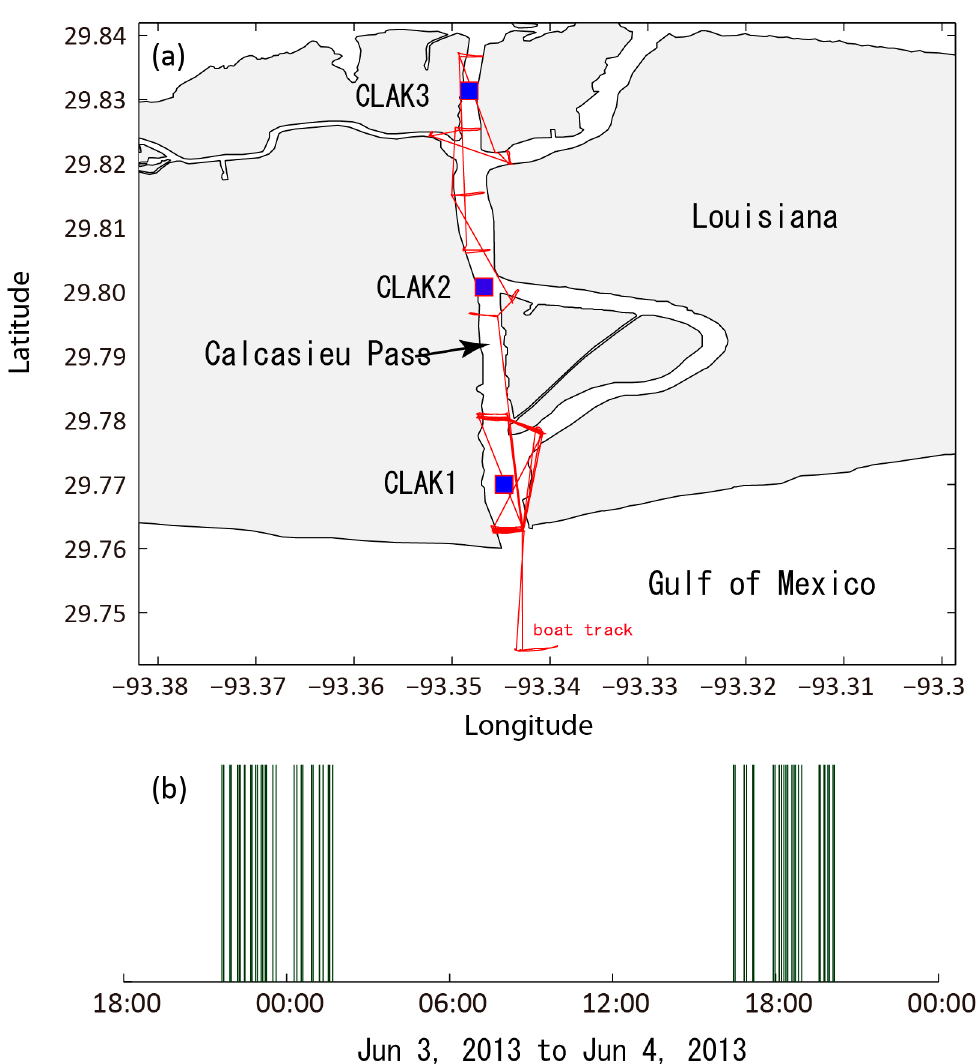
Figure 2. Boat-based survey inside the Calcasieu Pass on 3–4 June 2013. ( a ) Boat track of the survey; ( b ) the vertical bars indicate the times when the boat based survey was done across the transects. Each bar is essentially one occupation of one of the transects in Figure 2a.